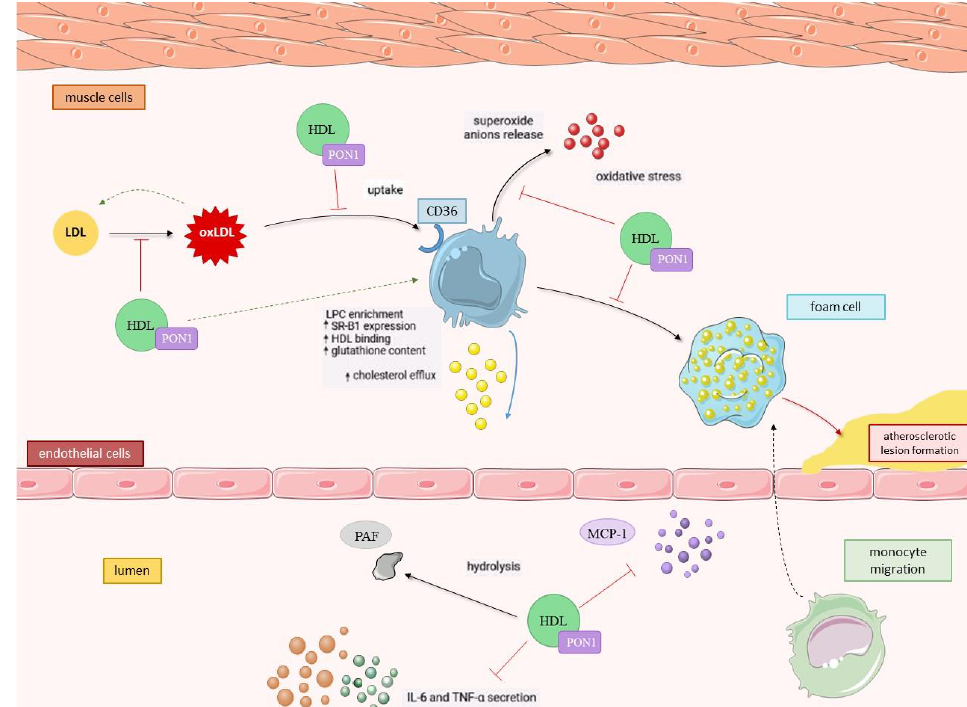
Figure 1. Schematic presentation of multifaceted PON1 antioxidative, antiatherogenic and anti- inflammatory activity. PON1 antioxidant activity is related to the suppression of oxidized LDL (ox-LDL) formation and uptake by macrophages via their CD36 scavenger receptors, which otherwise would lead to foam cell development. Other than that, PON1 contributes to atheroprotective activity of HDL in several other manners: stimulates macrophage cholesterol efflux, enriches macrophage plasma membrane with lysophosphatidylcholine (LPC), increases scavenger receptor class B type 1 (SR-B1) expression and HDL binding. The anti-inflammatory activity is related to platelet activating factor (PAF) hydrolysis by PON1 and inhibition of pro-inflammatory cytokines secretion, such as tumor necrosis factor- α (TNF- α ) and interleukin-6 (IL-6). PON1 is also able to inhibit monocyte migration to subendothelial space due to its interaction with macrophage chemoattractant protein-1 (MCP-1). Figure created with the use of Servier Medical Art by